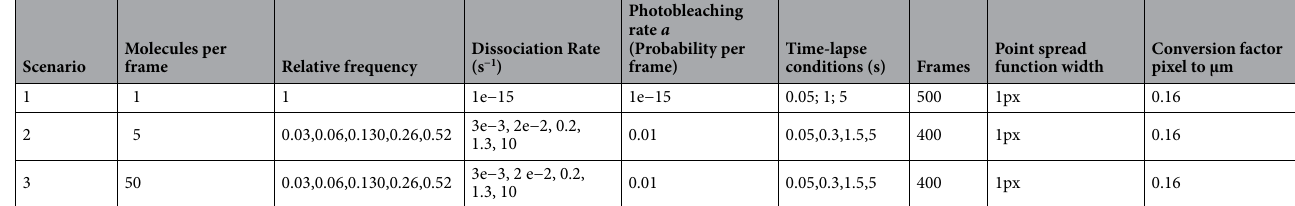
Table 1. Simulation parameters for time-lapse data. Scenario 1 (Fig. 3 Panel d) corresponds to a single spot that has an infinite residence time and does not exhibit photobleaching. Scenario 2 (Fig. 3 panel e) and 3 (Fig. 3 panel f) correspond to a molecule that exhibits five dissociation rates from chromatin and is subject to photobleaching at different spot densities per